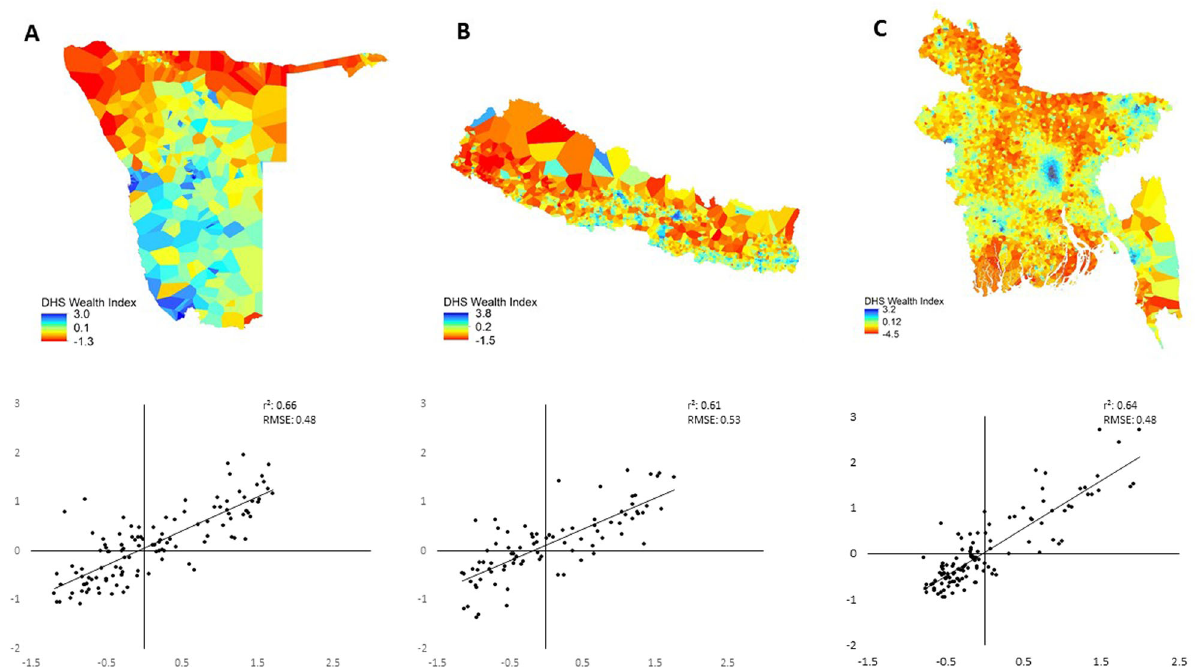
Fig. 4 National-level poverty estimates for each country. These maps illustrate the wealth index predictions for each Voronoi polygon, with associated out-of-sample validation statistics (scatterplot below corresponds to above map, showing predicted ( y -axis) vs. observed ( x -axis) values) for Namibia